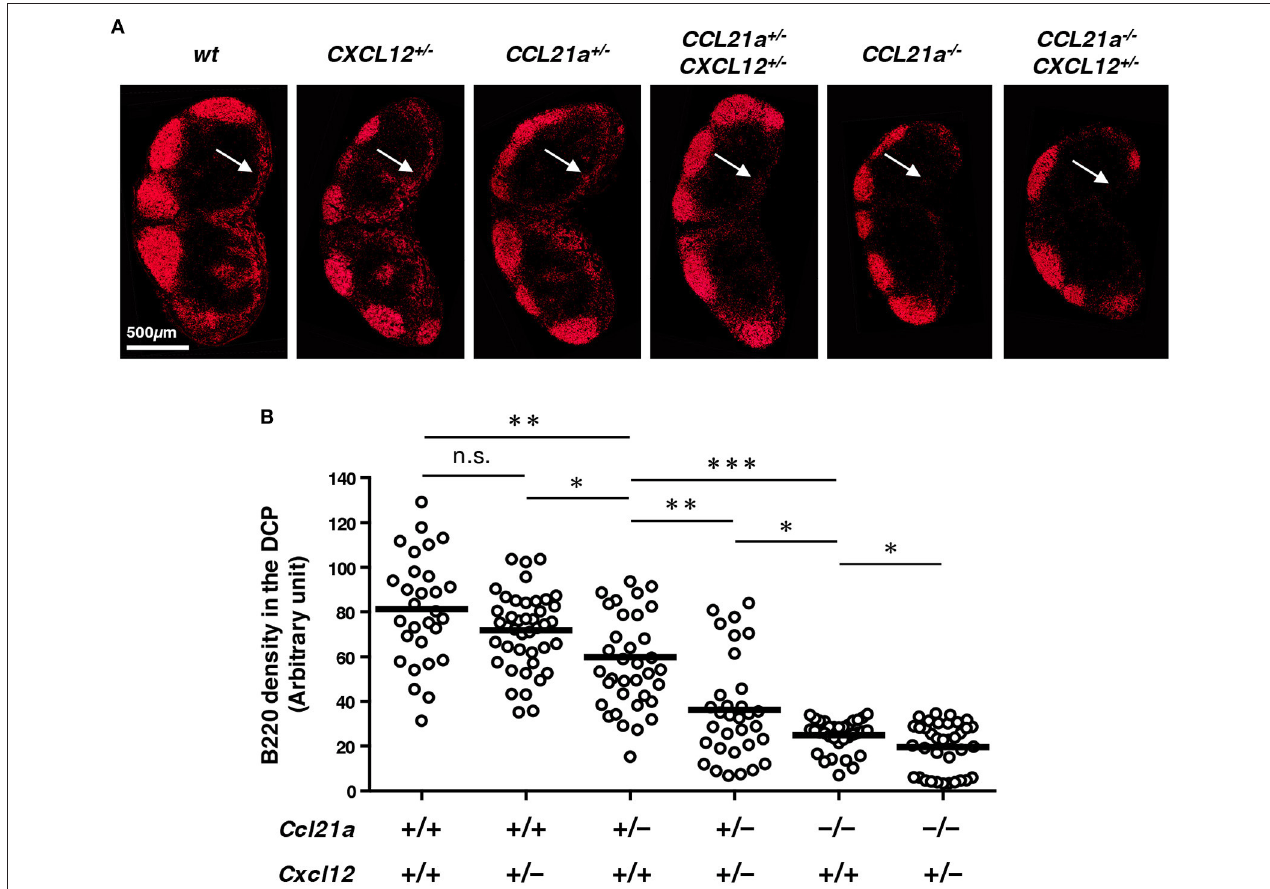
FIGURE 6 | CCL21-ser and CXCL12 synergistically control the localization of B cells in the DCP. (A) LN sections from mice with the indicated genotypes were stained for B220. Representative images of inguinal LN are shown. Arrows indicate the DCP. (B) Signal densities of B220 in the DCP area of various LNs are plotted (open circles). Bars: mean, n.s., not significant; * p < 0.05, ** p < 0.005, *** p <